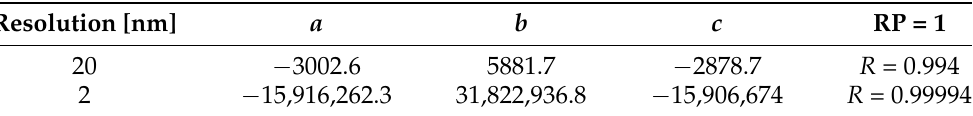
Table 5. Coefficient obtained with the polynomial fit resolution power (RP) vs. reflectivity ( R ): y = a · x 2 + b · x + c